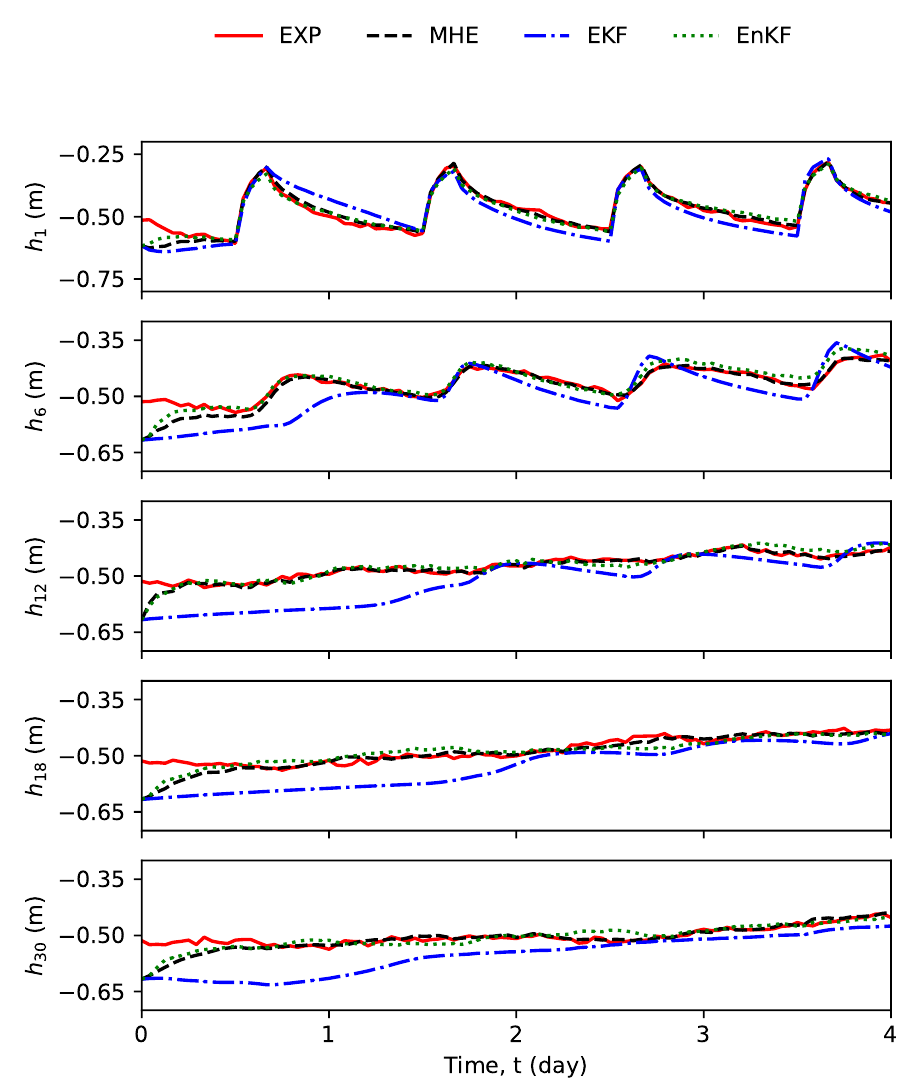
Figure 4. Selected trajectories of the process state and estimated states using MHE, extended Kalman filter (EKF) and ensemble Kalman filter